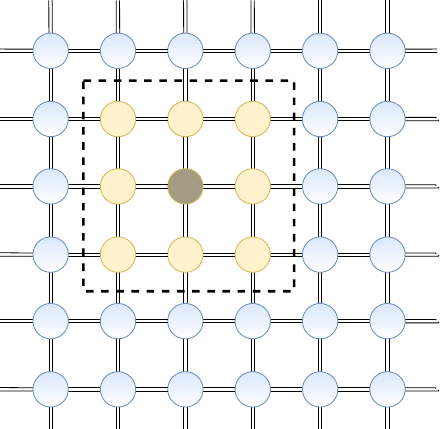
Figure 3. Cellular model for distributed genetic algorithms. All the circles represent nodes and in this architecture, differently from the island model, individuals can migrate from a node only to its neighbors. In this example, individuals from the central green node can migrate only to the adjacent yellow nodes—the dashed square region limits the nodes that exchange individuals with the green